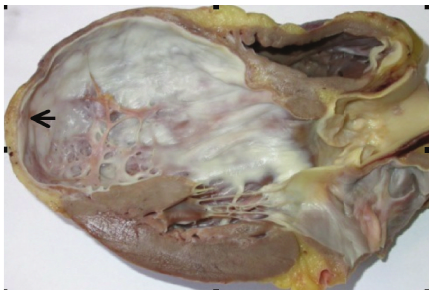
Figure 3: The expansion of a wide anterior and transmural infarct scar often leads to the formation of an apical left ventricular aneurysm that predisposes to left ventricular thrombosis. In this case, postinfarct remodelling is characterized by a great apical dilatation of the left ventricular chamber, together with a thinning of the infarcted segments